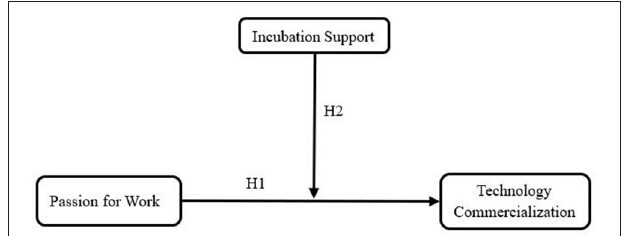
FIGURE 1 | The research